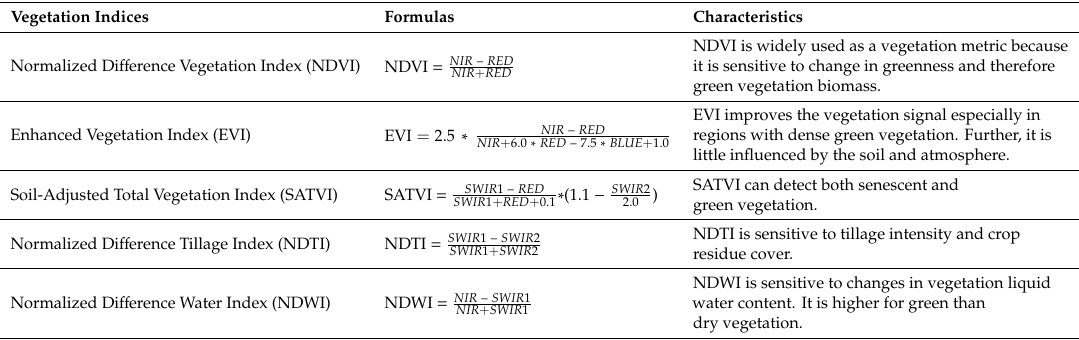
Table 1. Definition of vegetation indices calculated from Landsat imagery. Near-infrared band (NIR); red band (RED), blue band (BLUE); shortwave infrared band